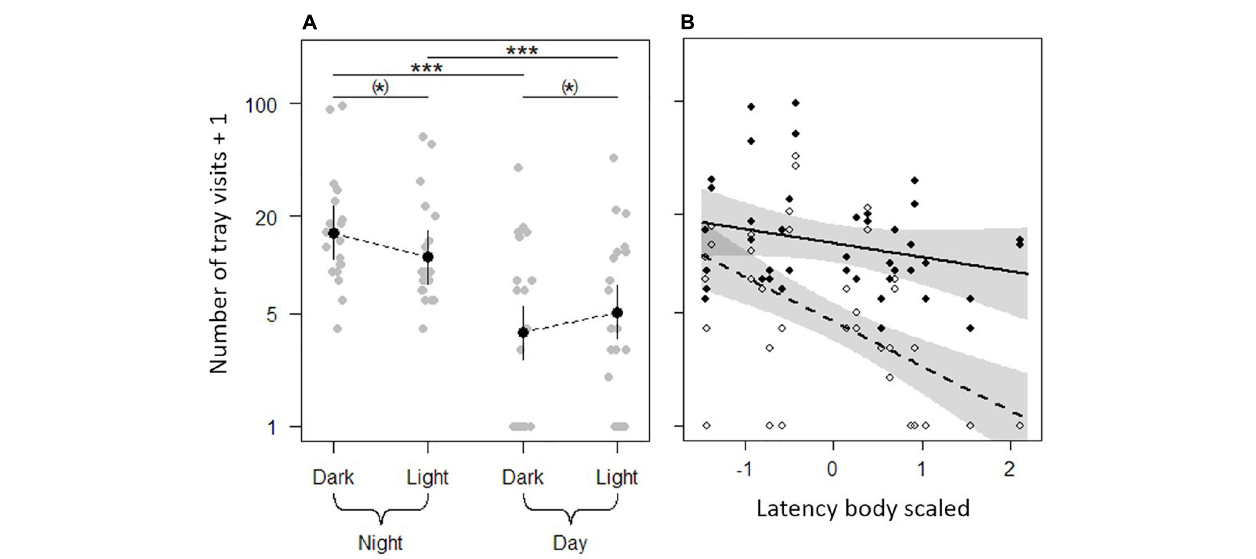
FIGURE 4 | Influence of (A) light treatment and daytime and (B) daytime and latency body (scaled) on the number of visits to seed trays on each side of the experimental arena of 21 bank voles. (A) Gray dots show the underlying raw data and black dots show the predicted means of the linear mixed effects model. Solid lines represent confidence intervals. * P < 0.1, *** P < 0.001. (B) Black dots and the solid line show the raw nighttime data and the prediction line from the linear mixed effects model, respectively. White dots and the dashed line show the raw daytime data and the prediction line from the model. Gray areas represent 95%-confidence intervals. The higher the latency body, the shyer is the animal. The y -axes are log scaled.